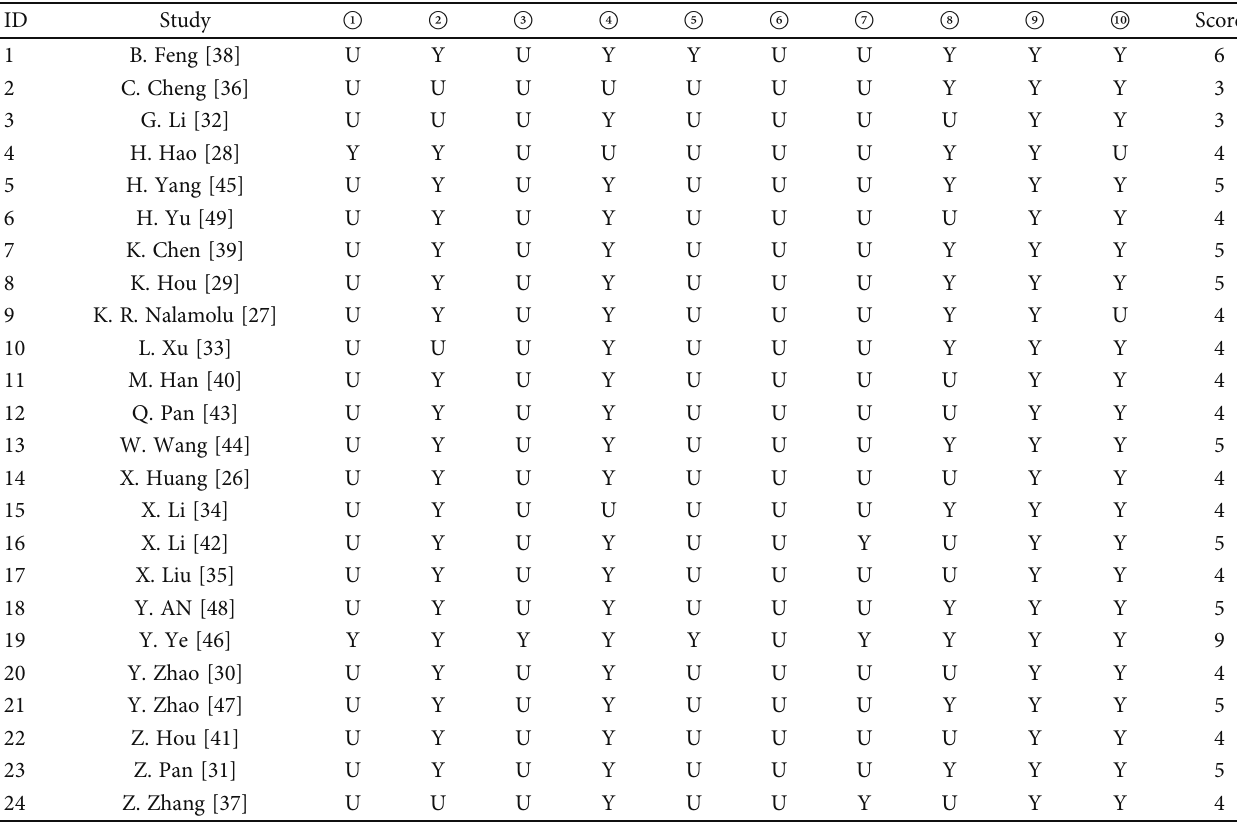
Table 2: Risk of bias of the included